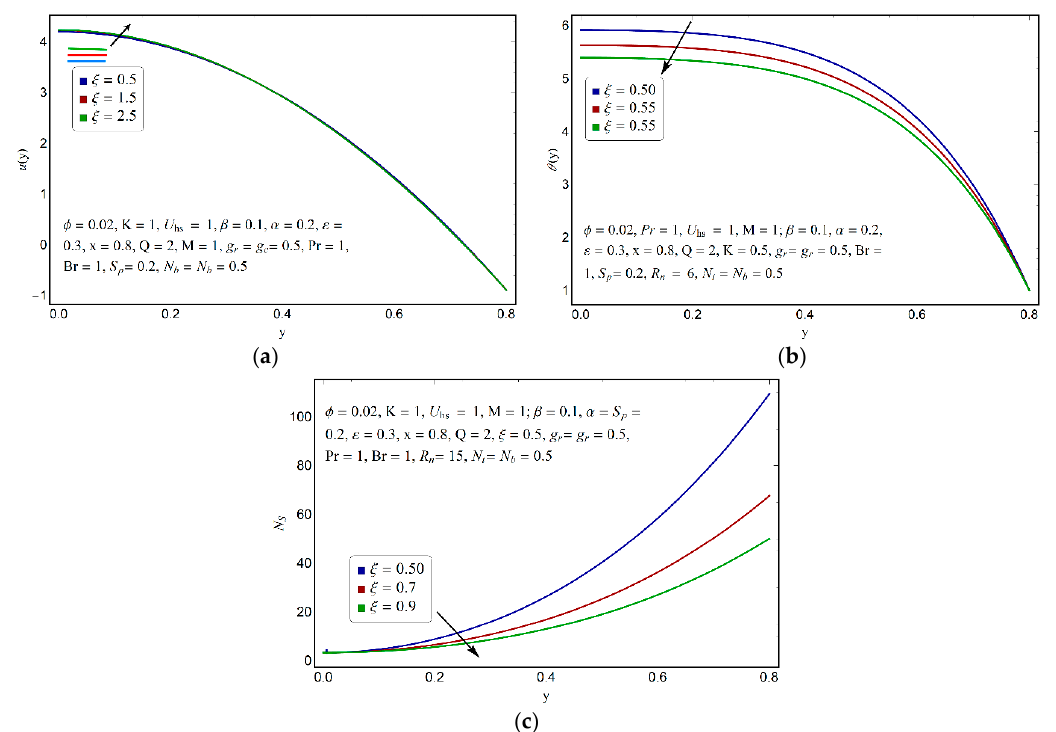
Figure 4. Impact of K on ( a ) the velocity profile, ( b ) the temperature, ( c ) the mass concentration, ( d ) the entropy number, and ( e ) the Bejan number.